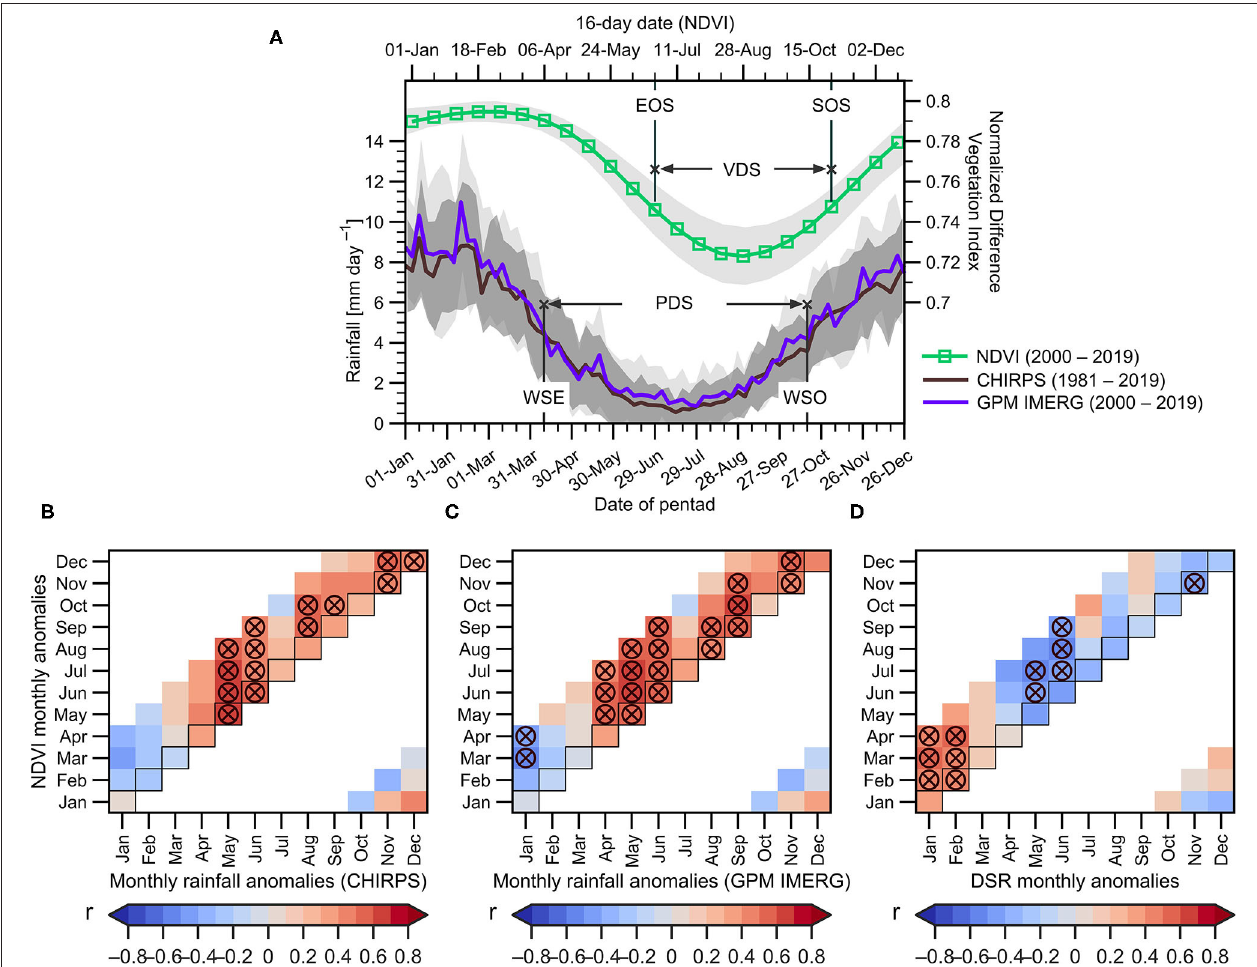
FIGURE 2 | (A) Mean annual cycle of NDVI (in 16-day time steps) averaged over the upper Madeira Basin (below 1,000 m.a.s.l, green line) for the 2000–2019 period, and the mean rainfall annual cycle (in pentads) averaged over the upper Madeira Basin estimated from CHIRPS (1981–2019, brown line) and GPM-IMERG (2000–2019, blue line) datasets. The mean dates of the wet season end (WSE) and onset (WSO), and the dry season period (PDS) are indicated. For the vegetation, the mean dates of the growing season end (EOS) and start (SOS), and the dry season period (VDS) are also indicated. For all cases, the standard deviation is indicated in shades. 2000–2019 monthly lagged correlations between NDVI anomalies averaged over the upper Madeira Basin (below 1,000 m.a.s.l) and: precipitation anomalies from (B) CHIRPS and (C) GPM-IMERG datasets, and (D) Downward Shortwave Radiation (DSR) anomalies. In (B–D) , the horizontal axis indicates the month correspondent to the average precipitation and DSR anomalies, while the vertical axis indicates the lag of response of the NDVI. Circles marked with the X symbol indicate significant correlations ( p < 0.05). Not computed correlation coefficients are shown in white